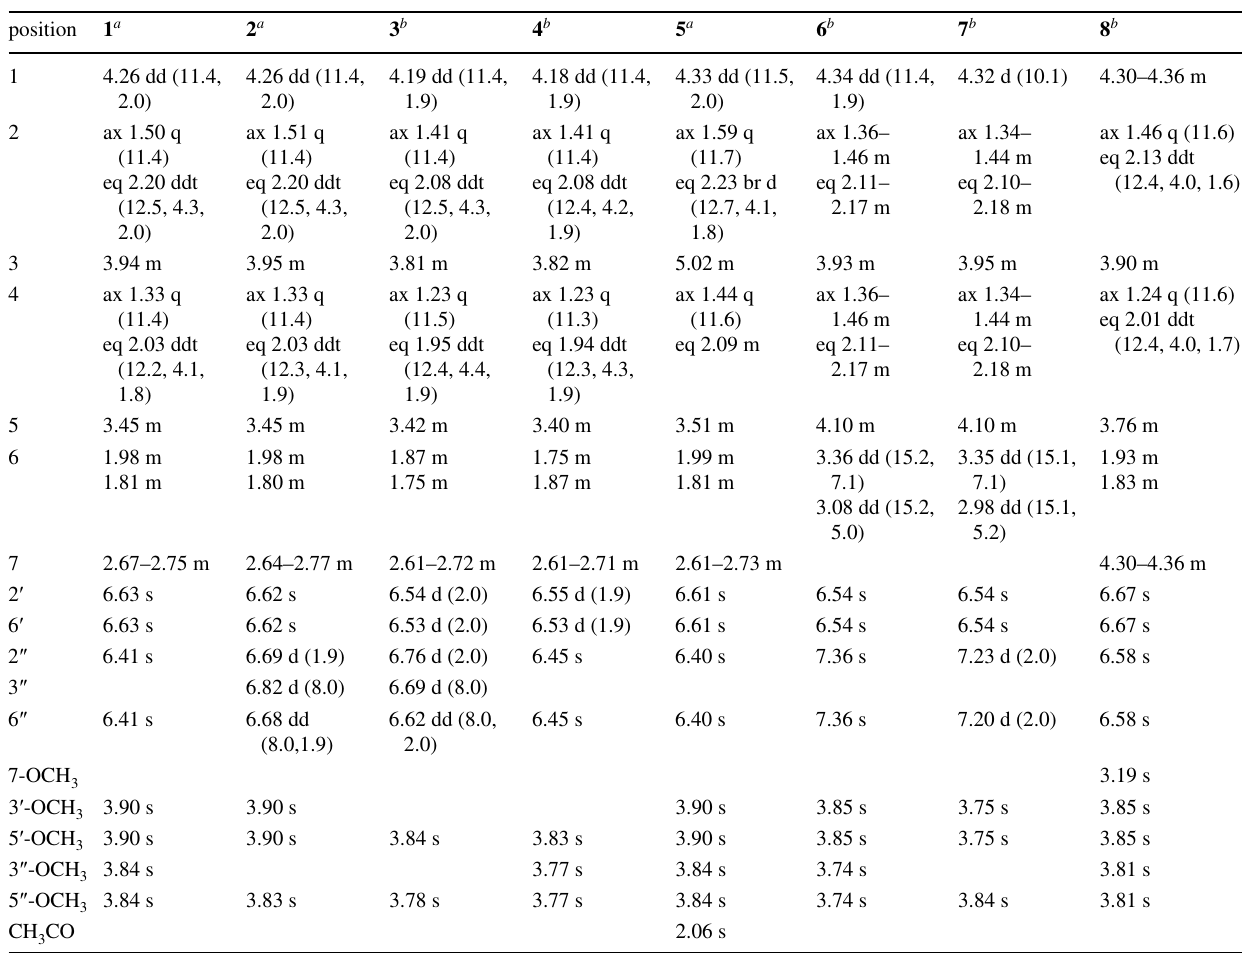
Table 1 1 H NMR (500 MHz) data for compounds 1 –